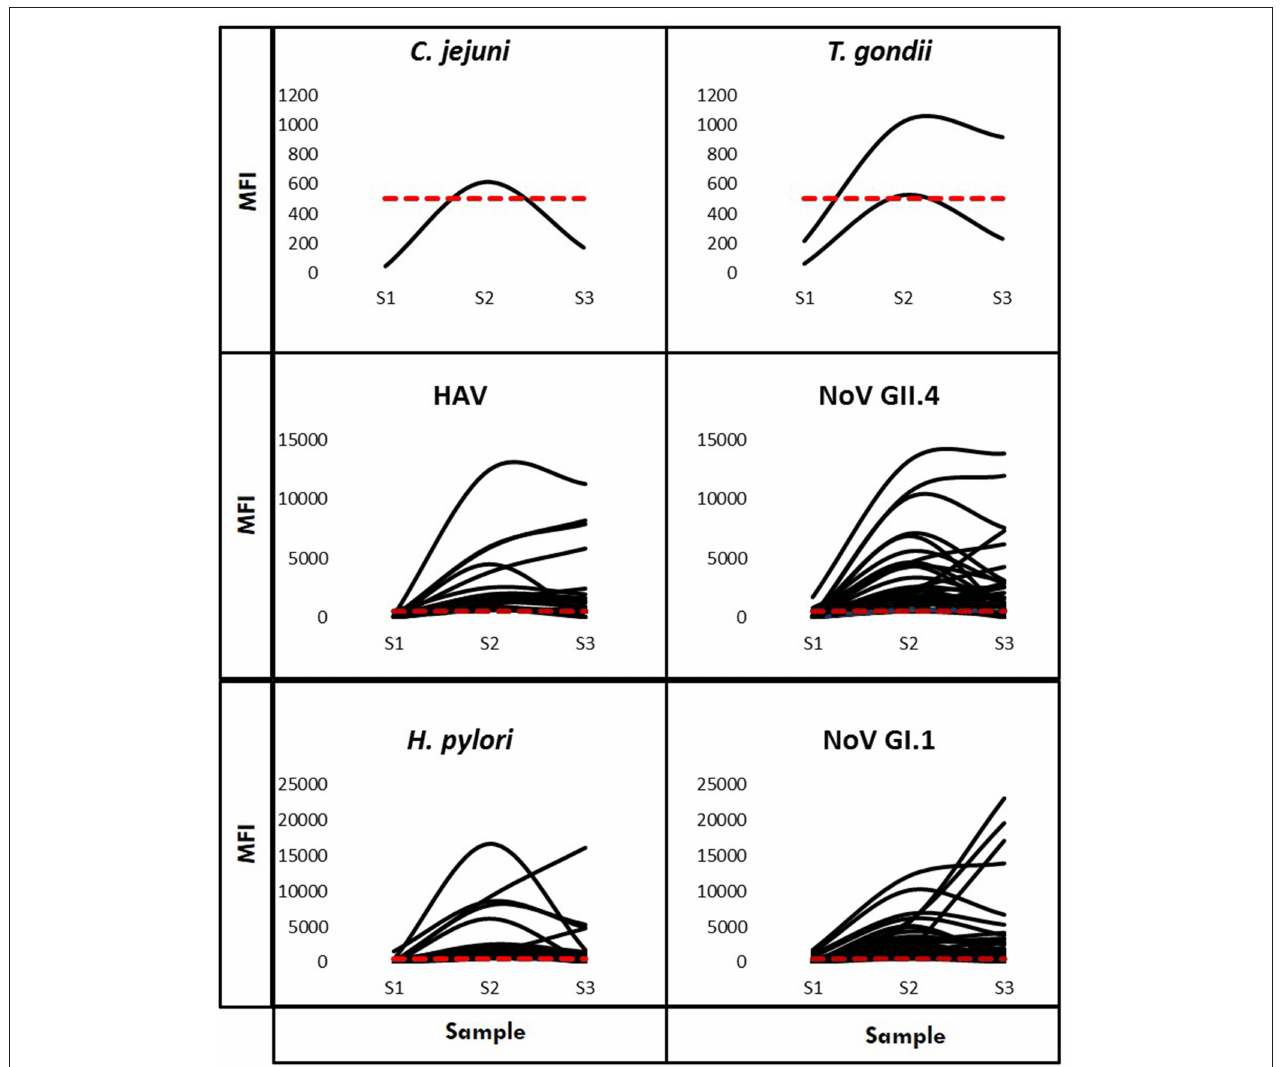
FIGURE 3 | IgG antibody response curves for the six multiplexed pathogens (Criteria B). Characteristic curves showing antibody responses measured in MFI from the baseline (S1) to the final (S3) sample for individuals who immunoconverted. The red dashed line represents the cut-off point (MFI =